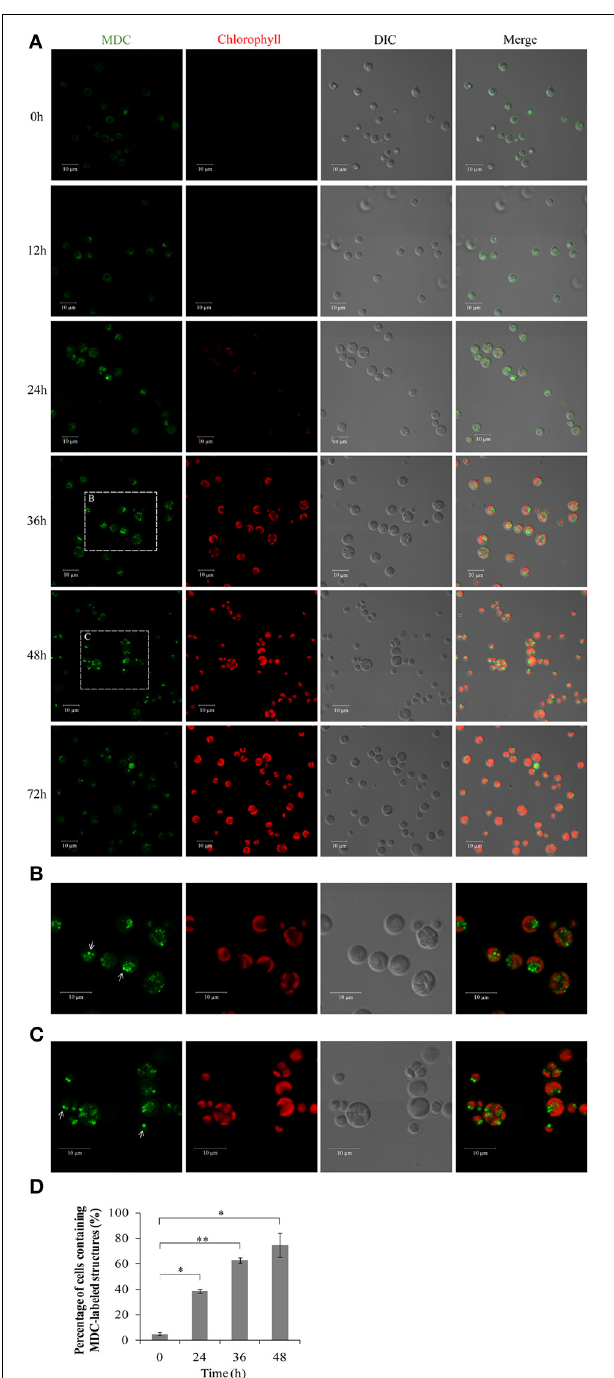
FIGURE 8 | Confocal microscope images of A. protothecoides during the HA transition. (A) MDC staining of A. protothecoides . Seven-day heterotrophic cells were inoculated into autotrophic medium and exposed to light at 28 ◦ C. Filtered air was supplied. Cells were harvested at the indicated times, stained with MDC, and observed using a confocal microscope. The MDC structures are shown in green and chlorophyll A is shown in red. Scale bar, 10 μ m. (B,C) Magnified images of A. protothecoides cells from (A) . Scale bar, 10 μ m. White arrows indicate MDC-stained autophagic bodies. (D) Quantification of MDC-stained